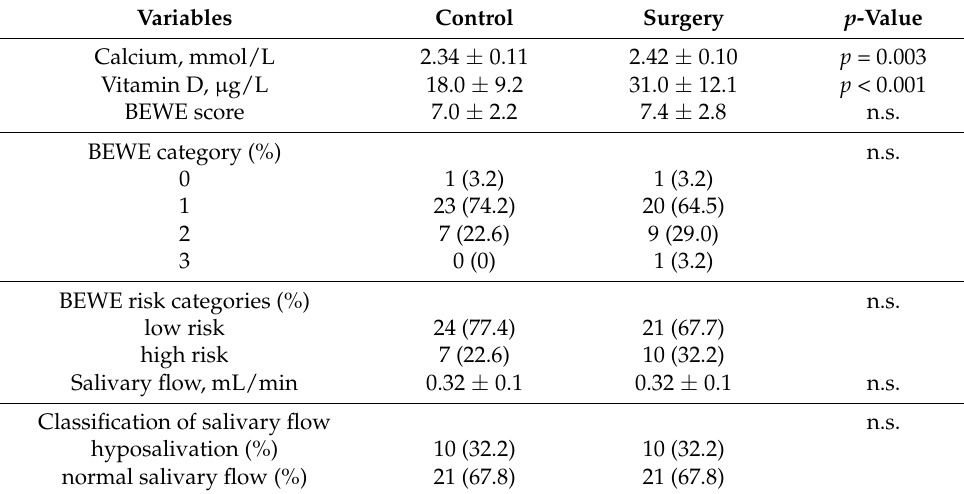
Figure 1. Portion of BEWE categories in control and surgery group. Table 4. Results of dental examinations .